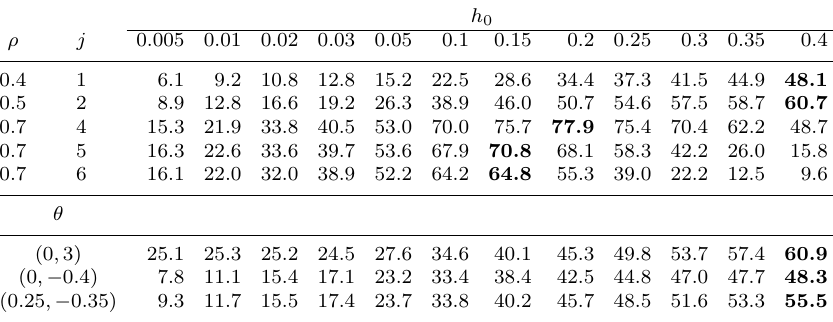
Table 5. AR (1) case with φ = − 0 . 3 ( M 3 model). Simulated power for alternatives g 1 and g 2 with n = 50 and 10,000 replications; h = h 0 n − 1 / 4 , kernel U [ − 1 ,